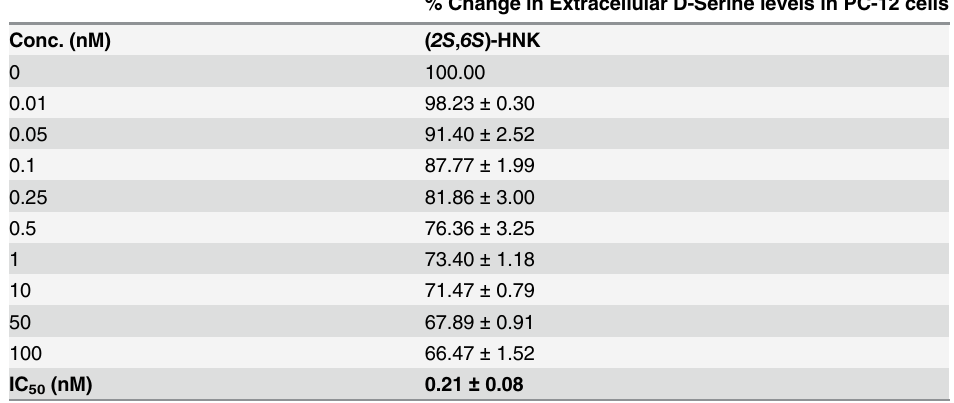
Table 4. The concentration-dependent decrease of extracellular D-serine concentrations produced by incubation of PC-12 cells with the (2S,6S)-HNK and the associated IC 50 value. The results are expressed as percent (%) maximum decrease from vehicle-treated PC-12 cells, means ± SD, n = 3 indepen- dent